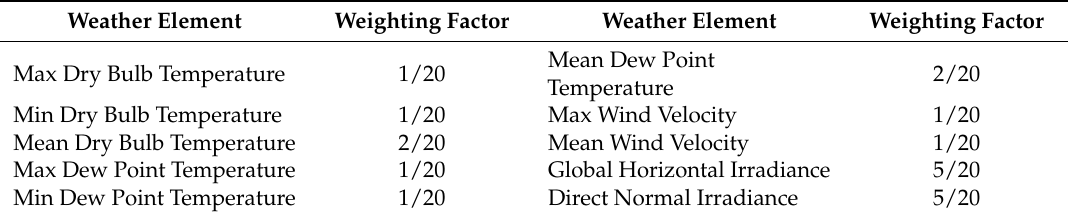
Table 3. Weighting factors for the Finkelstein-Schafer (FS)